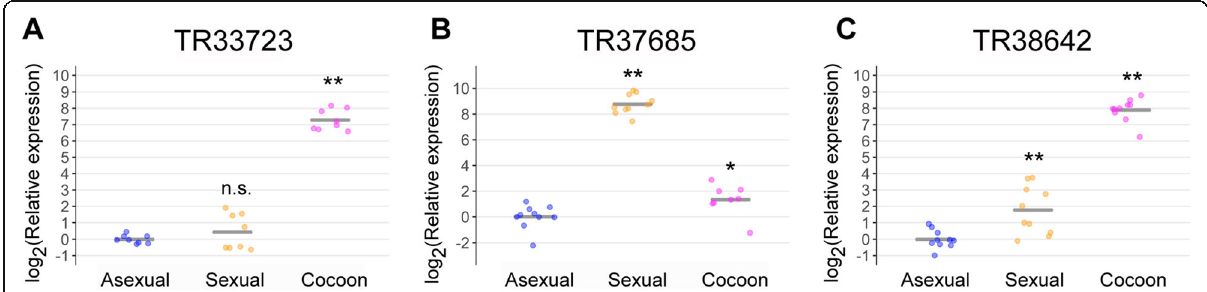
Fig. 1 Comparison of TR33723, TR37685, and TR38642 mRNA levels in asexual worms, sexual worms, and cocoons. qRT-PCR data are shown relative to the expression level (normalized to the Dr-ef1a mRNA level) in the asexual worm; log 2 (relative expression) on the vertical axis indicates −ΔΔ Ct. Each circle indicates an individual asexual worm, sexual worm, or cocoon sample. The bars in the plots indicate the average − ΔΔ Ct values. Asterisks indicate significant differences compared with asexual worms (Tukey ’ s HSD test: ** P < 0.01; *** P <